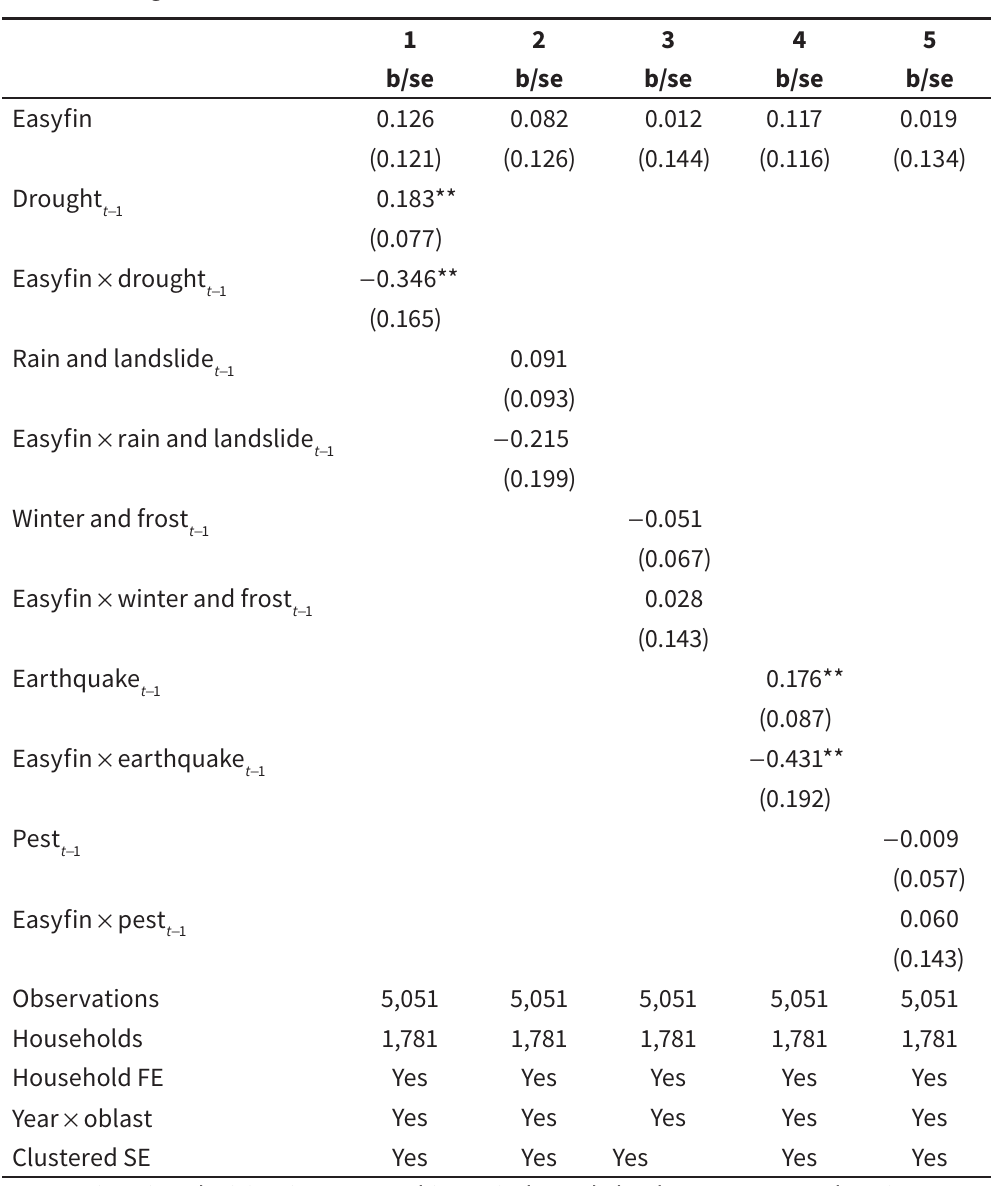
Migration, informal finance and